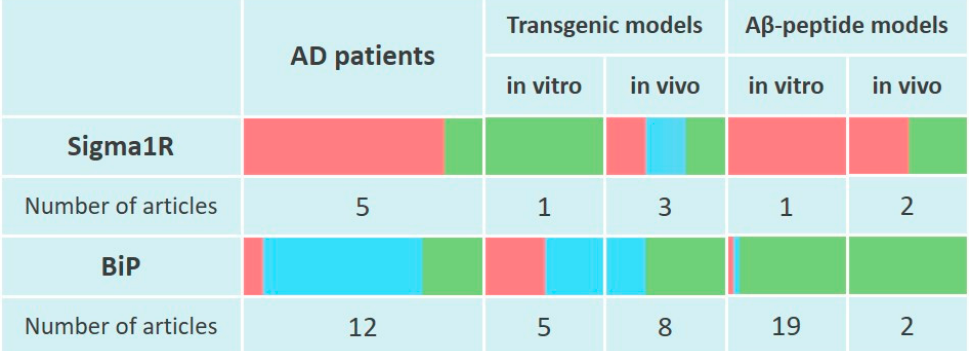
Figure 1. Changes of Sigma1R and BiP chaperones expression in the pathogenesis of Alzheimer’s disease. The table reflects experimentally recorded changes in the expression of Sigma1R and BiP chaperones, denoted in relative units, according to Sections 3.1 and 3.2. To visualize mRNA or protein levels following markers were used: green—content increased, blue—content did not change, red—content decreased.